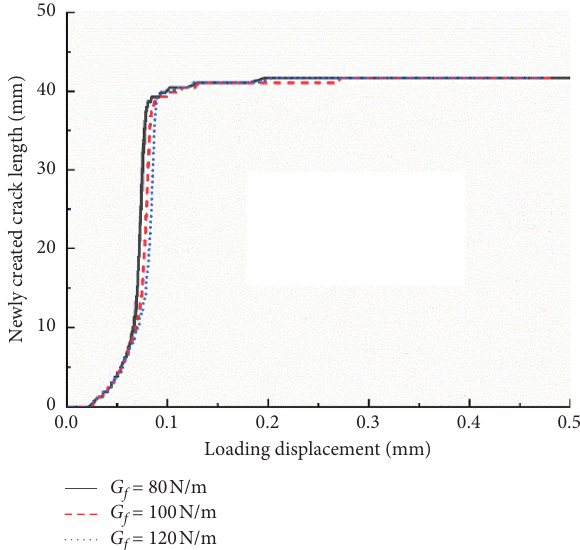
Figure 14: Effect of cohesive strength on the crack length development.